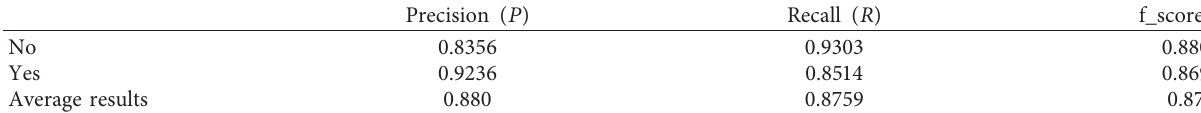
Table 1: Results of whether or not the player conducts the game experience.